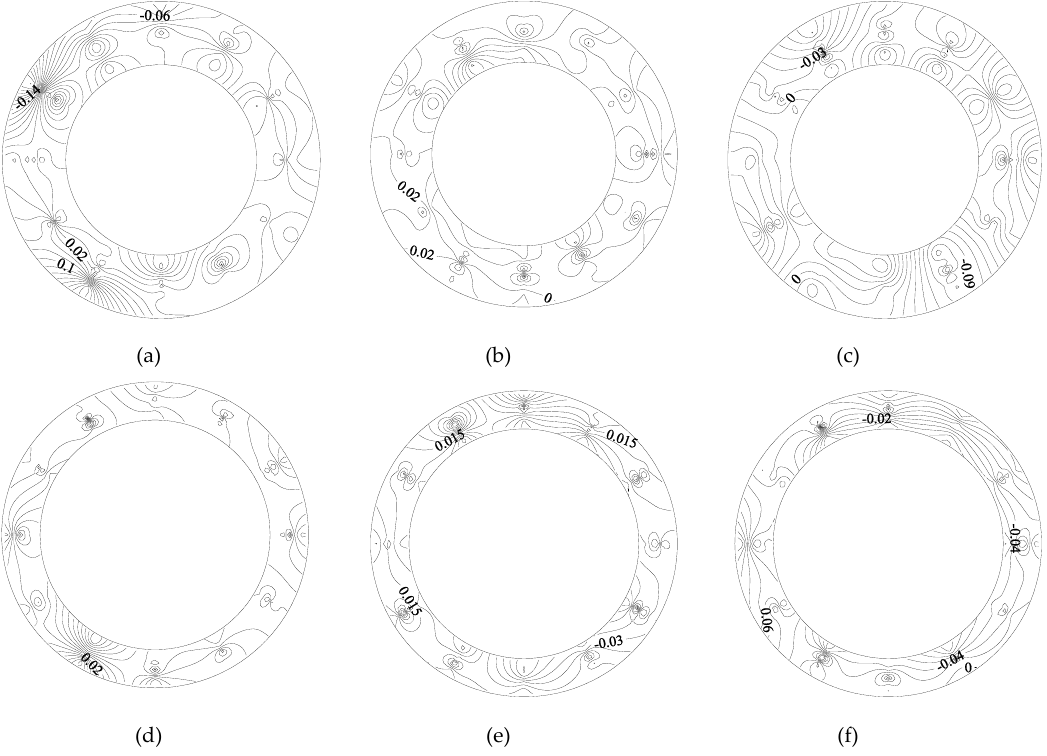
Figure 17. Radial flow velocity distribution of annular gap sections of the capsules: ( a ) L / d = 2.5, rear section; ( b ) L / d = 2.5, middle section; ( c ) L / d = 2.5, front section; ( d ) L / d = 2.14, rear section; ( e ) L / d = 2.14, middle section; and ( f ) L / d = 2.14, front section.